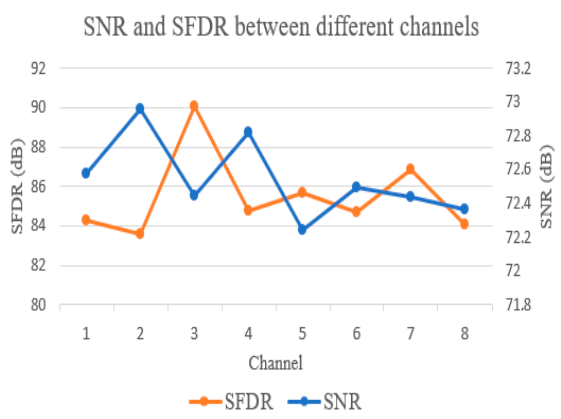
Figure 15. SNR and SFDR of acquisition system.